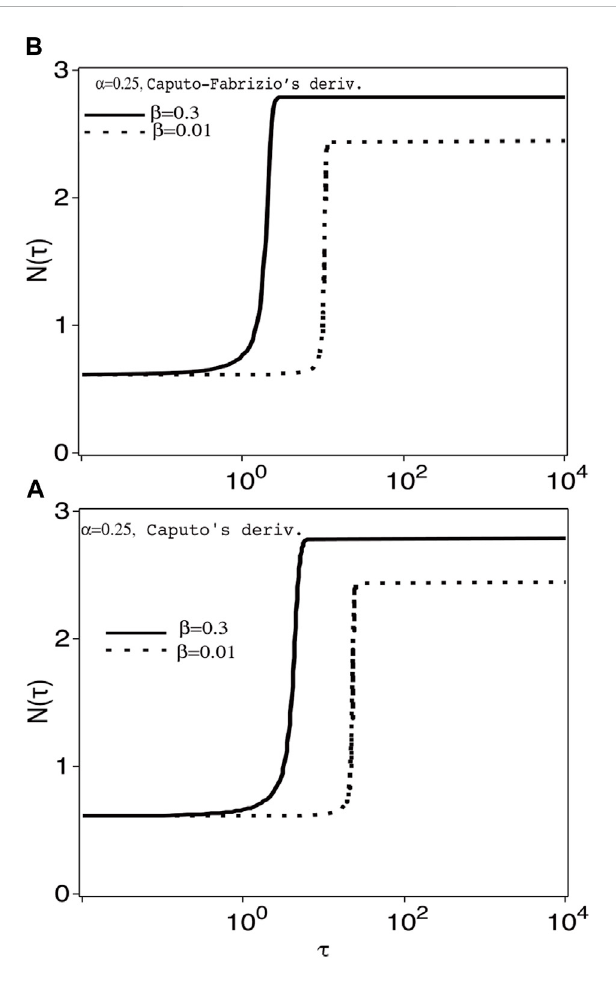
FIGURE 4 AsFigure2,butat fi xedvalueof α =0.25,anddifferent β =0.01,0.3in the case of: (A) Caputo ’ s, and (B) Caputo-Fabrizio ’ s, fractional derivatives.